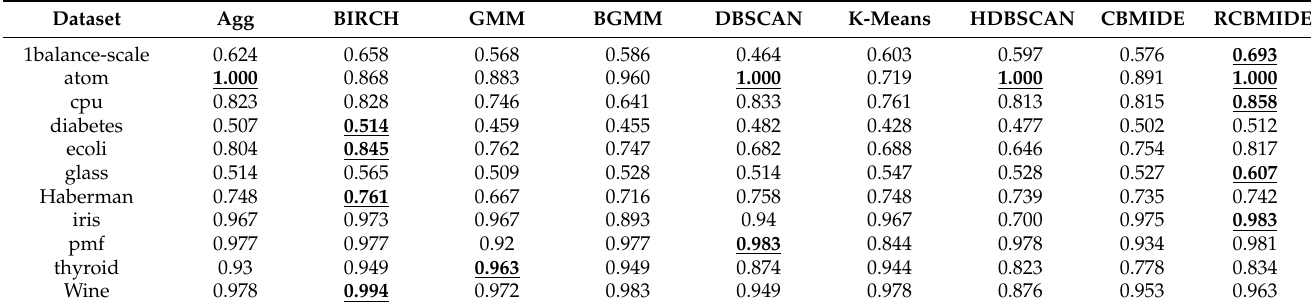
Table 2. Different clustering methods results for lower dimensions datasets.